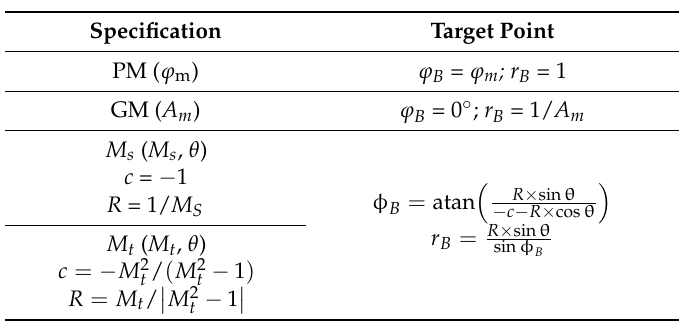
Table 2. Target points for the four frequency domain